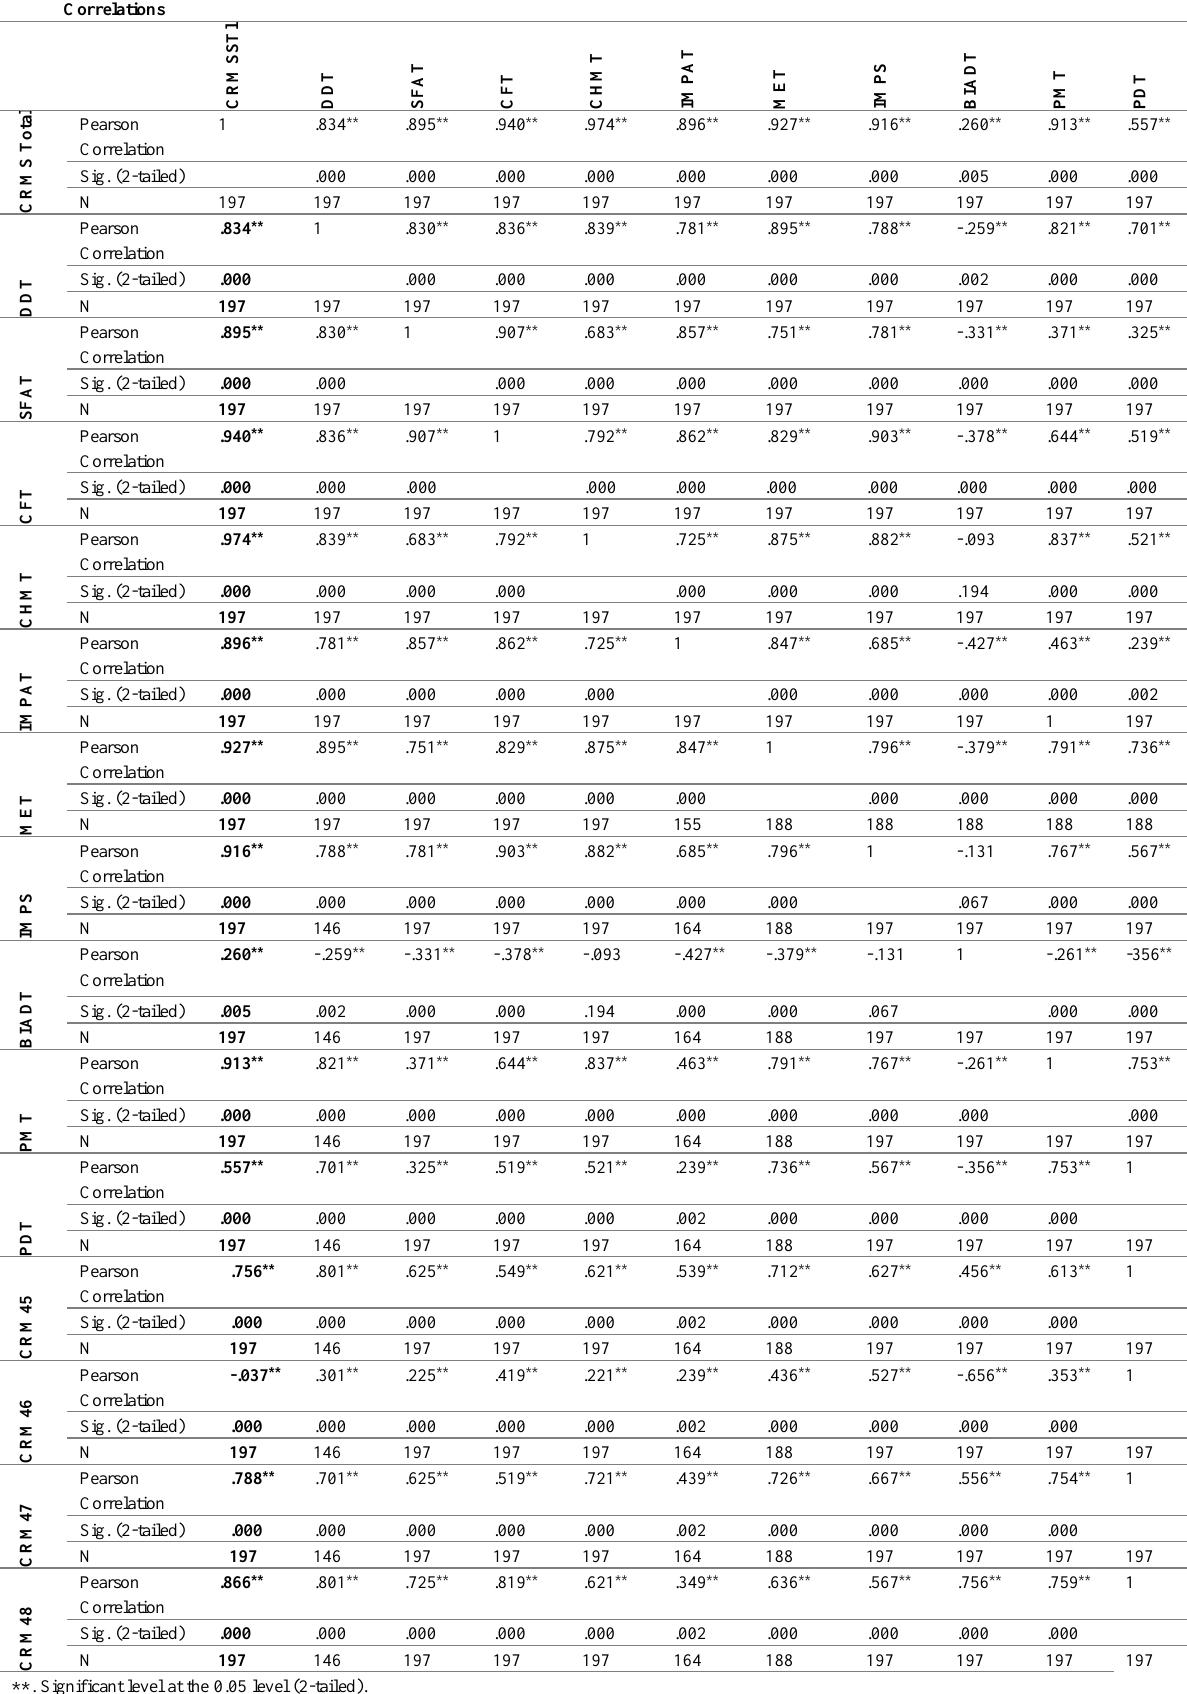
Table 3: Correlations Matrix of Critical Success Factors in CRM Strategy in the Local Government Authorities Correlations